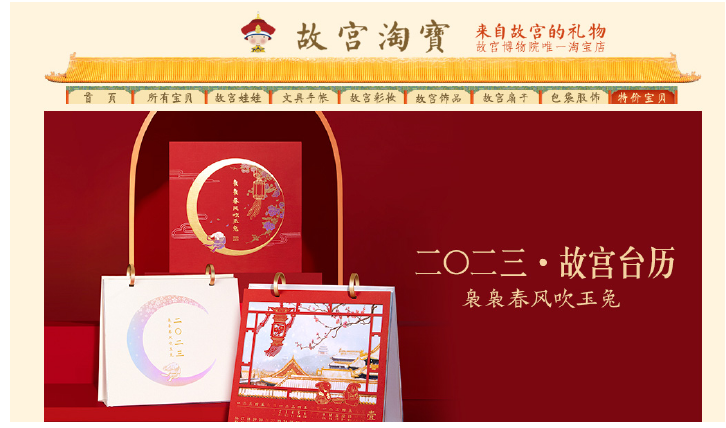
Figure 16. Palace Taobao.